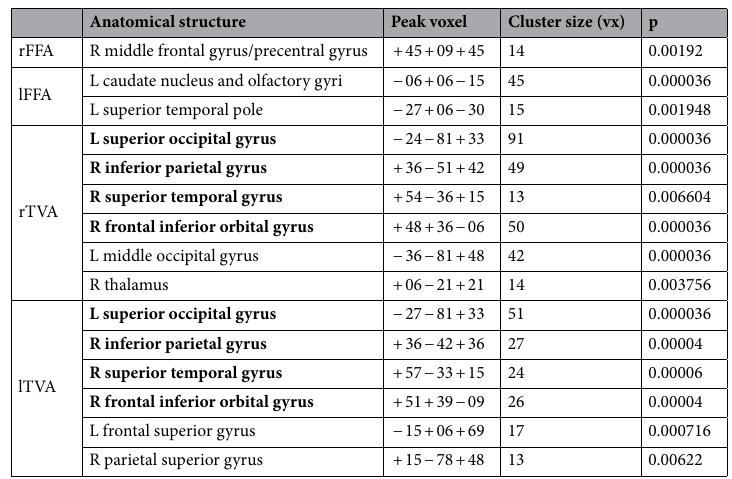
Table 1. Multi-voxel pattern analysis (MVPA). RSFC correlates of individual voice- and face-preferential responses in TVA and FFA. Voxel-wise threshold was set to p < 0.001 and whole brain FWE-corrected at cluster level with additional Bonferroni-correction for the number of tested regressors (4) leading to an effective cluster threshold of p < 0.0125. R right, L left. Overlapping clusters for the rTVA and lTVA are marked in bold. Voxel size 3 × 3 × 4 mm 3